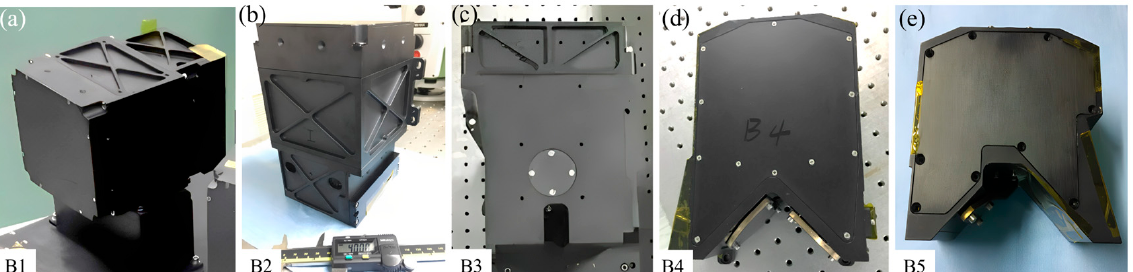
Figure 16. Spectrometers of five sub-bands. ( a – e ) for spectrometers of B1–B5.